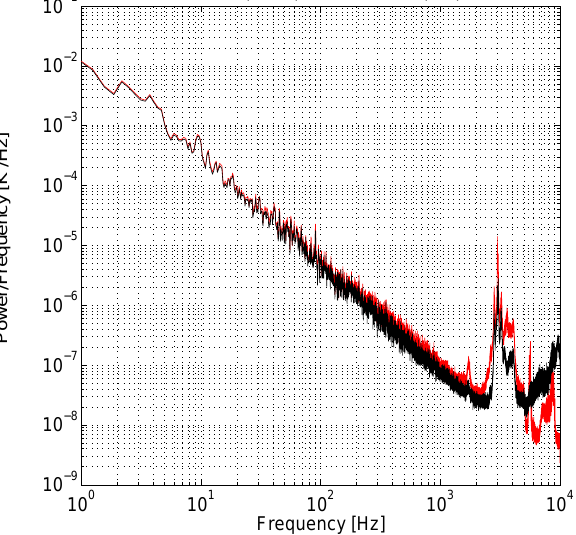
PSD of temperature fluctuations, intensive mixing in cloud top region UFT−M1 (black) and UFT−M2 (red)